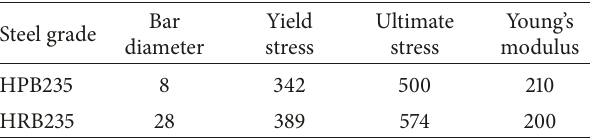
Table 3: Mechanical properties of reinforced bar.